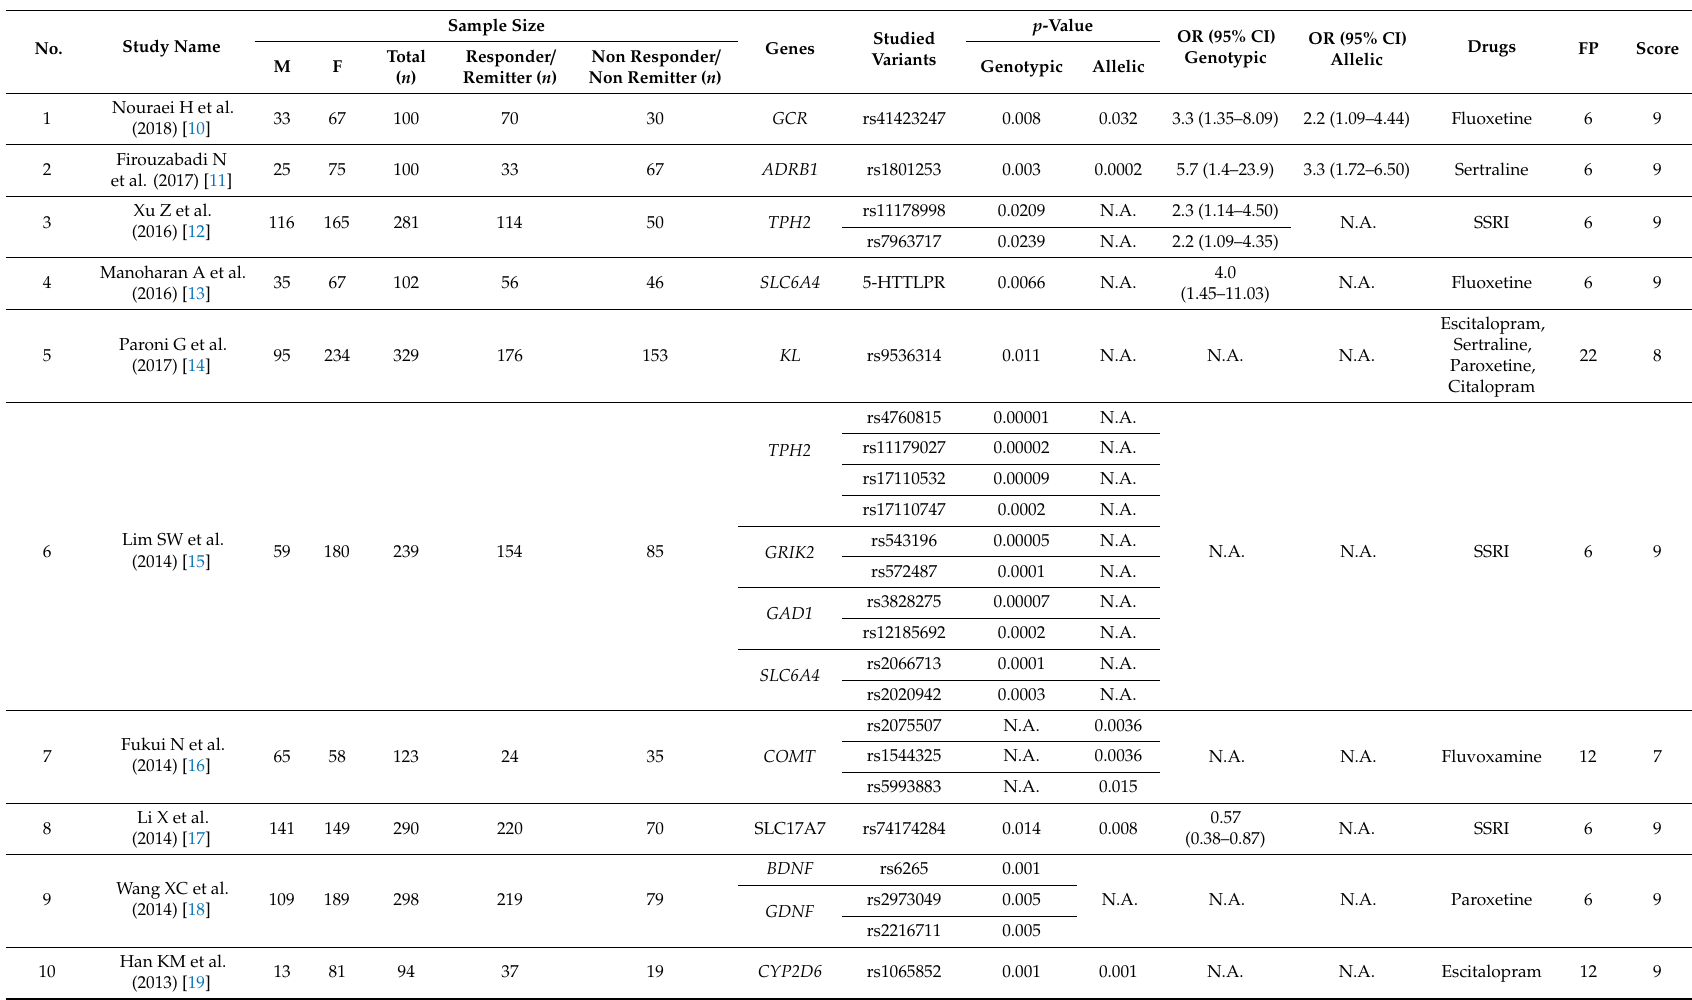
Table 1. Characteristics of included studies for assessment of the association between genetic variants and SSRIs response in major depressive disorder.